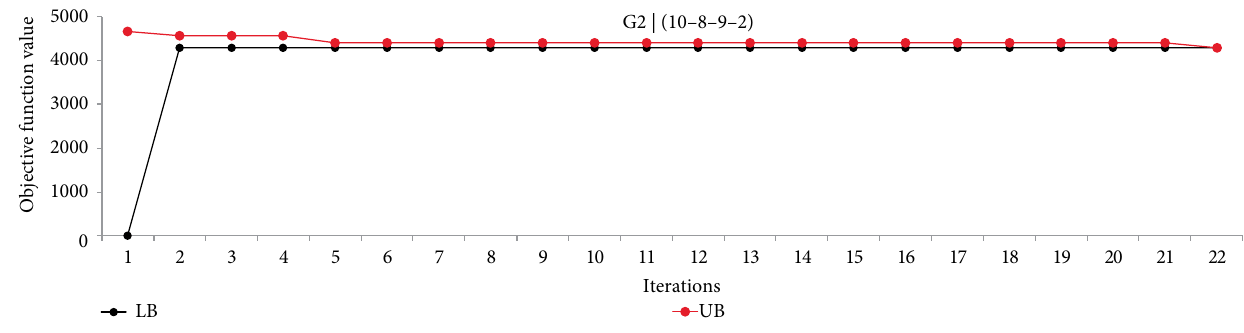
Figure 6: The instance G2 | (10-8-9-2) did converge its LB and UB values. As a result, both UB and the LB computed are considered optimal solutions.